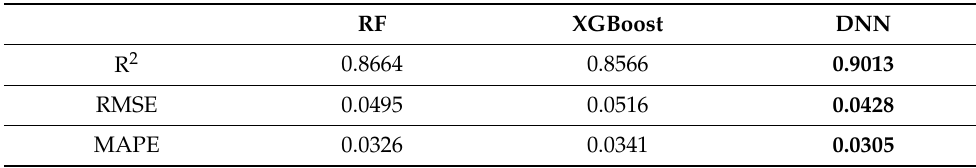
Table 7. Statistical measures for ML-based models tested against the blind dataset provided for Oldroyd-B and Giesekus